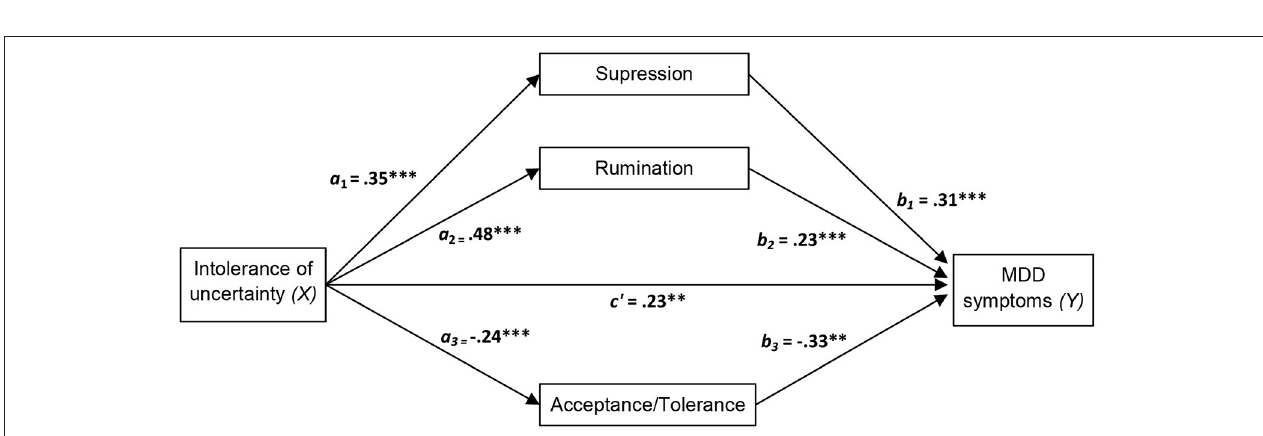
FIGURE 2 | Diagram of the parallel multiple mediator model for the direct and indirect effects of negative affect on major depressive disorder (MDD) symptoms via emotion regulation strategies (acceptance/tolerance, suppression, and rumination). Fully standardized regression coefficients are shown. See Table 5 for indirect and total effect coefficients. a , effect of X on a mediator; b , effect of the mediator on Y ; c ′ , direct effect of X on Y . ** p < 0.01; *** p < 0.001.